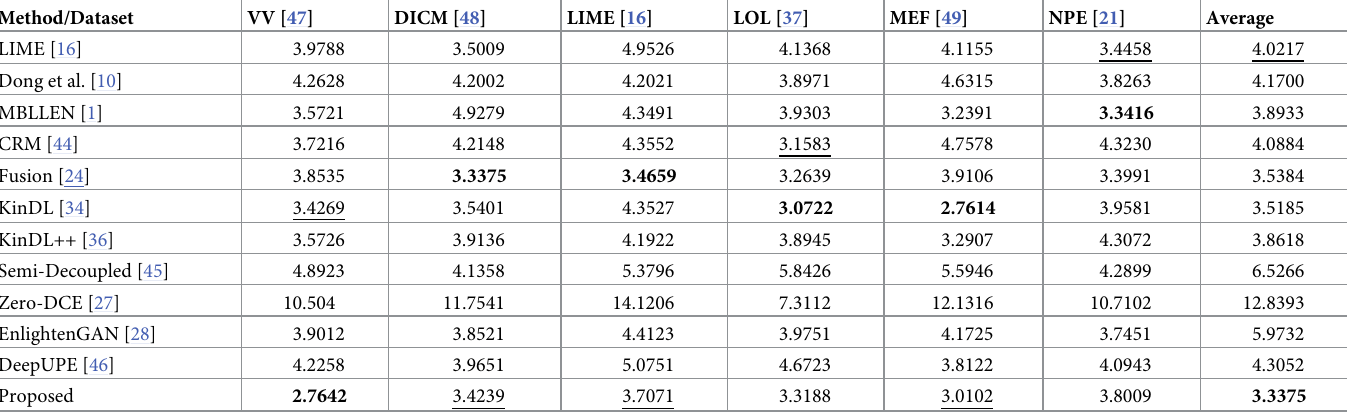
Table 3. Naturalness Image Quality Evaluator (NIQE) comparison between eleven low light enhancement methods on six different datasets. The best score is in bold and the second best is underlined.